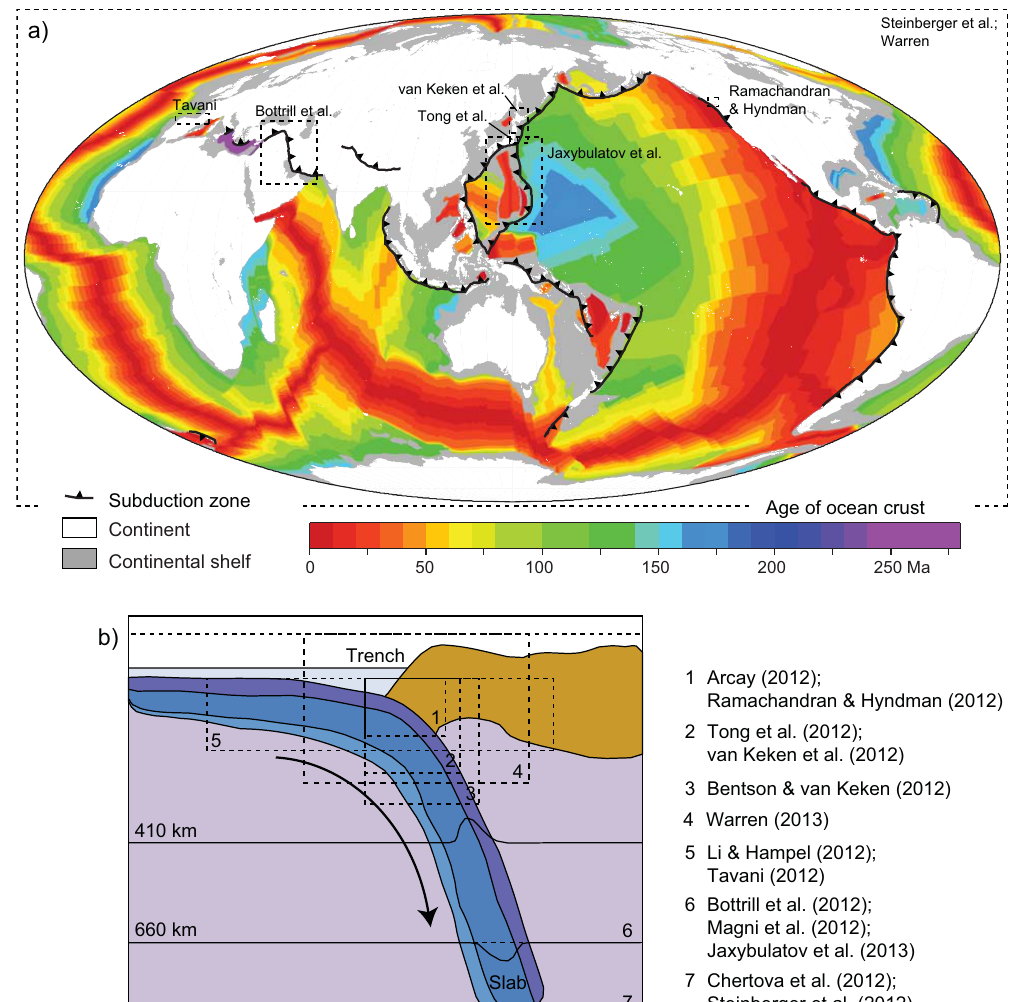
Fig. 1. (a) Map of present-day subduction systems, and (b) schematic subduction zone cross-section with areas of study of the Subduction Zones special issue indicated as dashed boxes. Age of ocean crust from M¨uller et al.